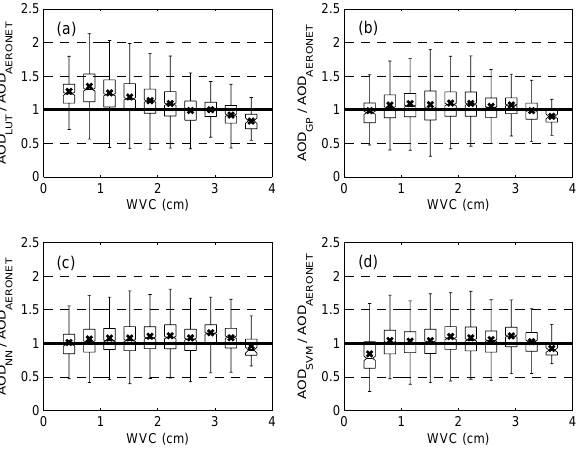
Figure 5. Solar surface radiation (SSR), aerosol optical depth (AOD) and water vapour content (WVC) for a fixed solar zenith angle (48.50–51.50 ◦ ) for (a) look-up table (LUT) and (b) measure- ments (Meas). The predicted AODs for (c) LUT and (d) neural net- work (NN) are the same for SSR, WVC and